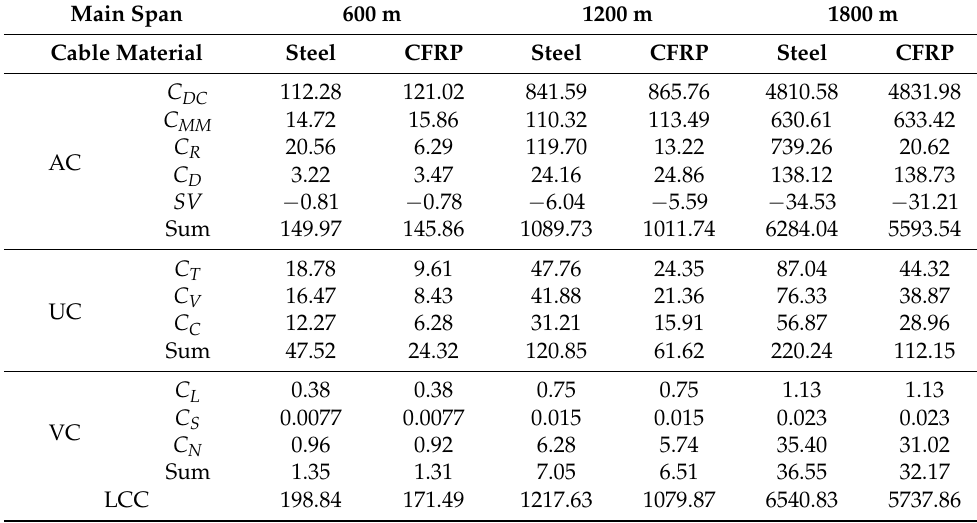
Table 11. Detailed life-cycle cost results of the investigated cable-stayed bridges (unit: USD 10 6 ). Main